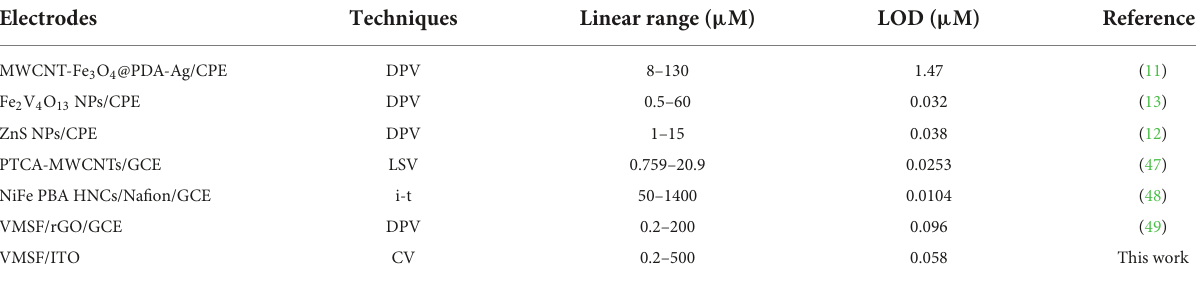
TABLE 2 Comparison of the electrochemical performances of VMSF/ITO for G detection with other reported electrochemical sensors. Electrodes